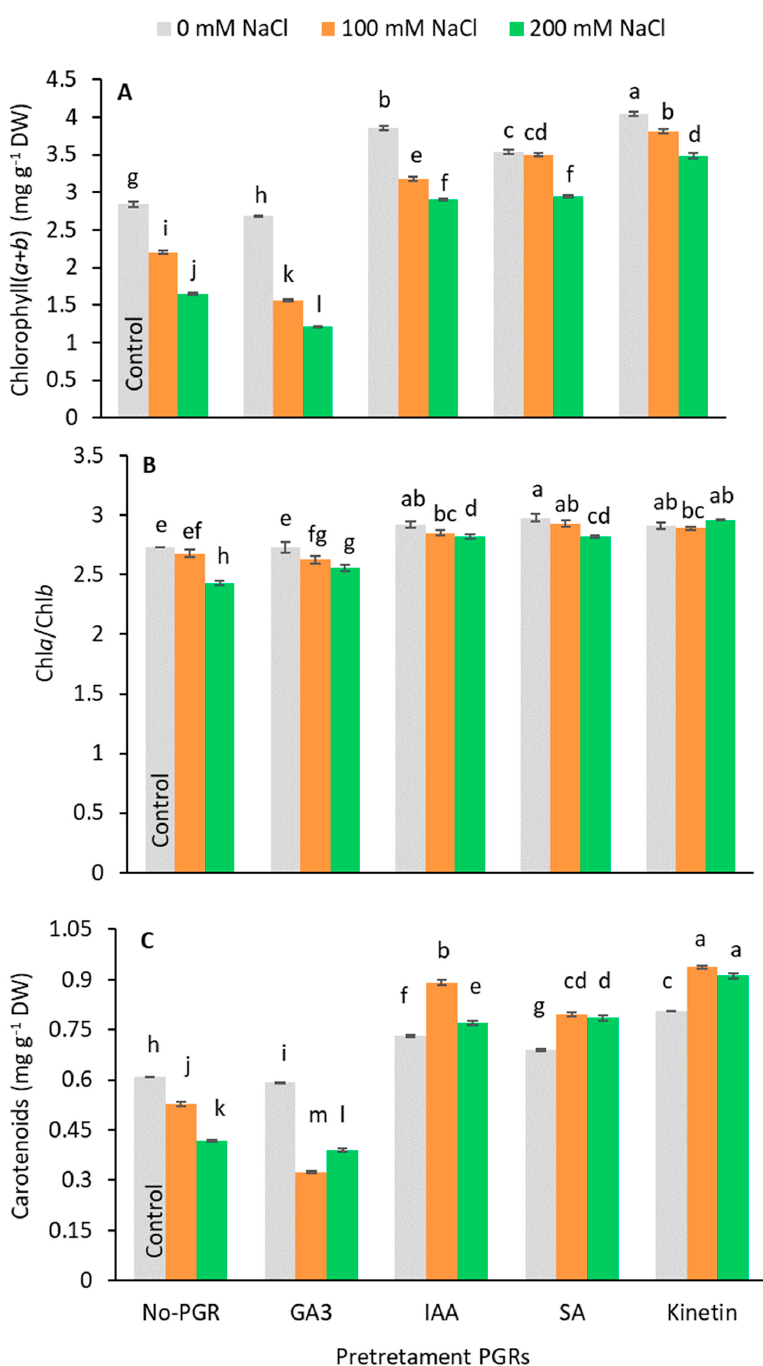
Figure 4. Effect of salt stress on chlorophyll total ( A ), ratio Chlorophyll a /Chlorophyll b ( B ), and carotenoids ( C ) in leaf tissue of Olea europaea plants pretreated with plant growth regulators (PGRs). Data are expressed as mean ± SE (n = 4). Means followed by the same letter are not significantly different according to the LSD test ( p < 0.05).